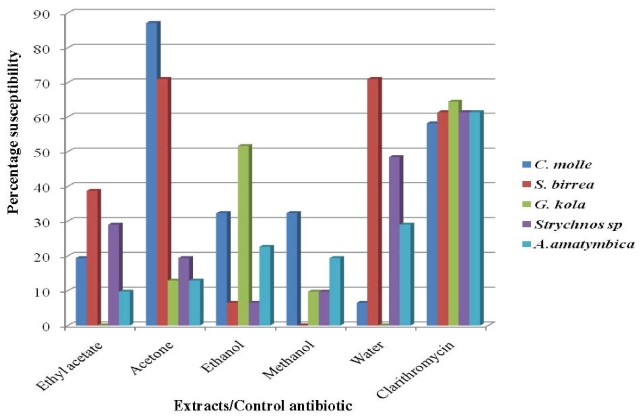
Activity of plant crude extracts on H. pylori by agar well diffusion method. Percentage susceptibilities are representative of the number of strains whose zone of inhibition diameter is ≥14 mm.